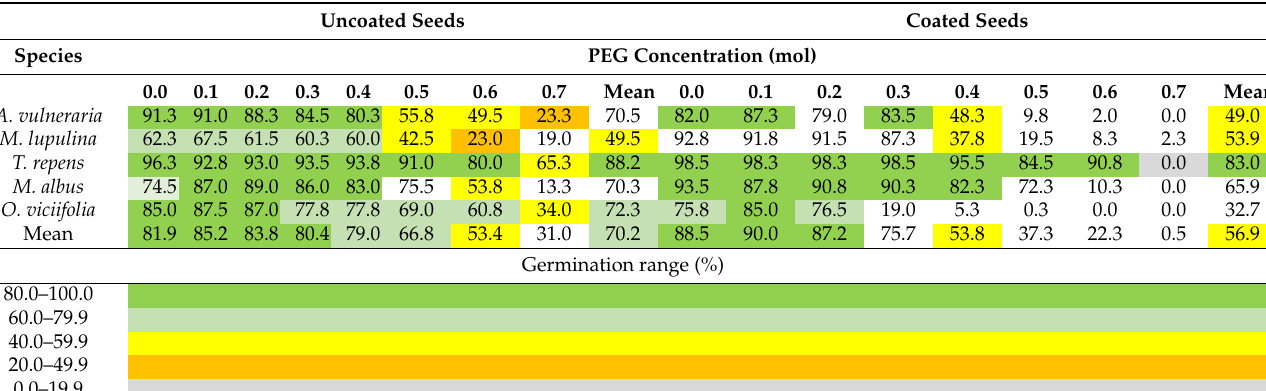
Table 2. Percentages of germinated seeds in the US and CS treatments with the distinction of individual model plant species and drought simulation degrees. Uncoated Seeds Coated Seeds Species PEG Concentration (mol) 0.0